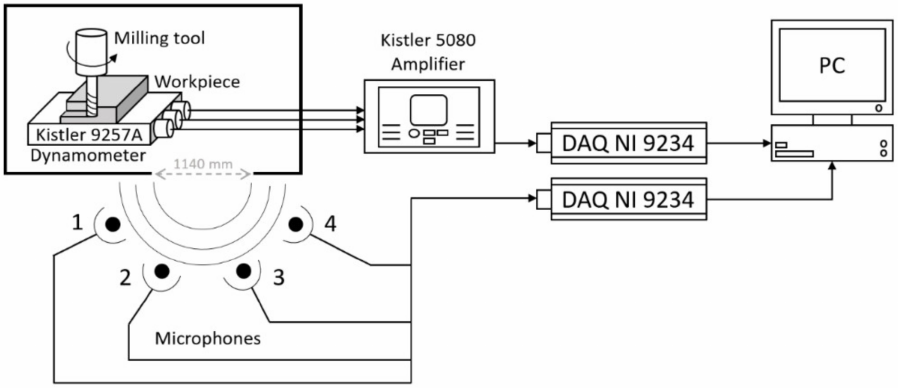
Figure 2. Diagram of the elements of the experiment.